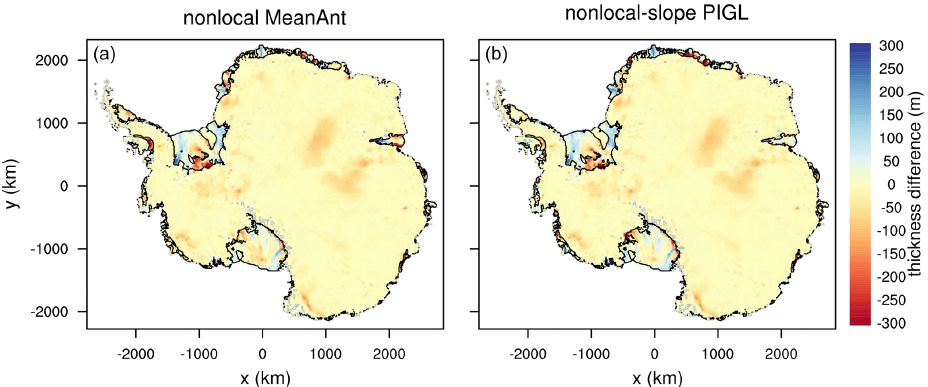
Figure 2. Change in ice thickness (m) between the start and end of two 20kyr CISM spin-ups at 4km resolution, for two combinations of melt parameterization and calibration: (a) nonlocal-MeanAnt and (b) nonlocal-slope-PIGL. The initial state is based on observations (Morlighem et al., 2019), and positive values indicate where the spun-up ice state is thicker than observed. Black lines show boundaries of floating ice at the end of each spin-up.